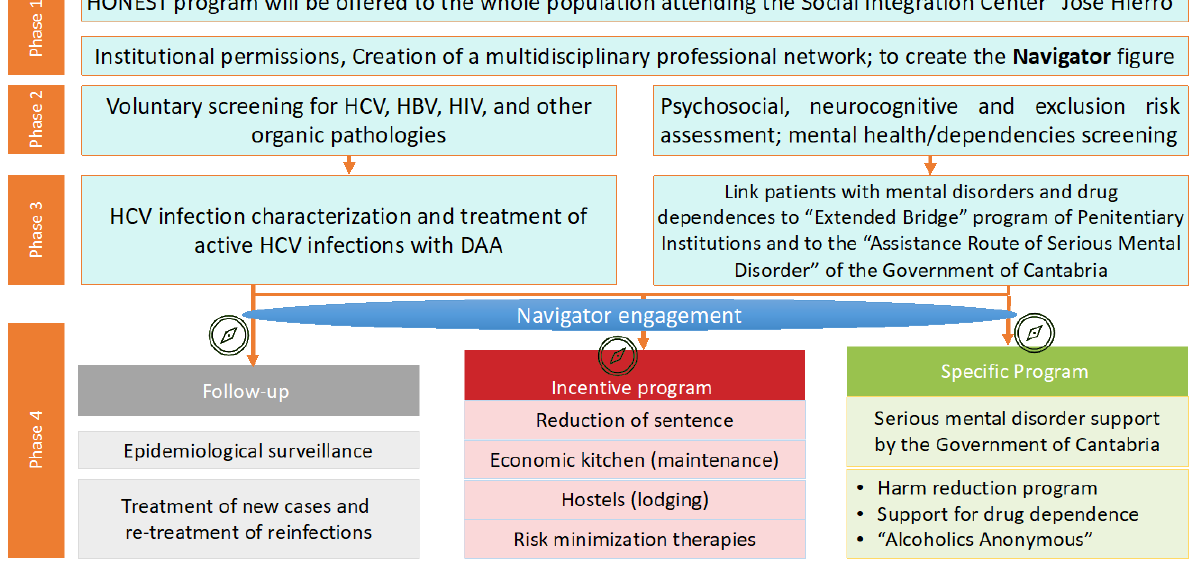
Figure 1. Phases of the study. Detailed design of the project.